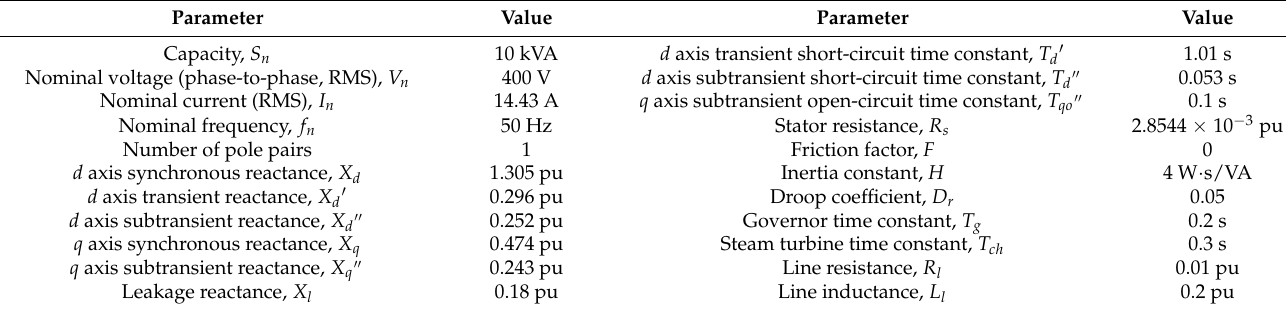
Table A3. Parameters of the synchronous generator (SG) and